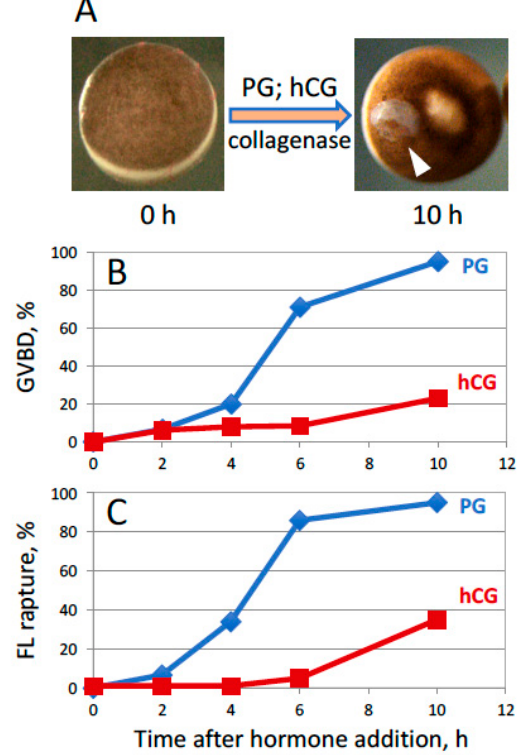
Figure 2. Effects of PG and hCG on the follicular oocytes in the presence of low concentrations of collagenase. ( A ) Morphology of isolated follicles before and after hormonal treatment in the presence of 50 µg/mL collagenase. A white arrowhead in the panel points to a remnant of the follicle layer that is still attached to the oocyte after follicle rupture. ( B , C ) Time courses of GVBD and follicle rupture, correspondingly. The experiment was repeated with five batches of follicular oocytes obtained from di ff erent animals, and the results of a single batch experiment are